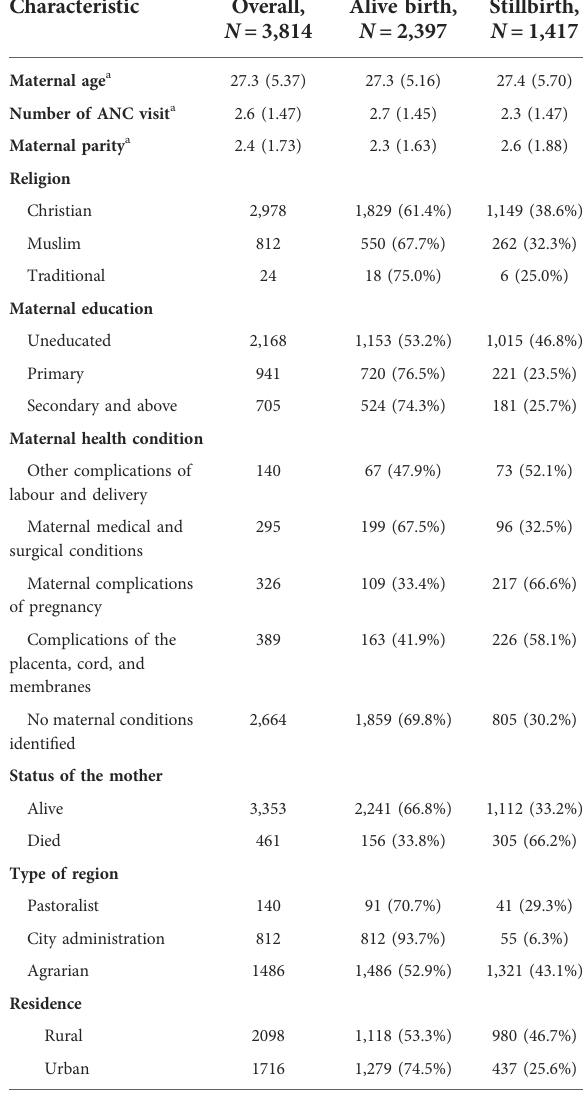
TABLE 3 Selected background characteristics of the deceased perinate ’ s mother by outcome status of the perinate in Ethiopia, 2021.